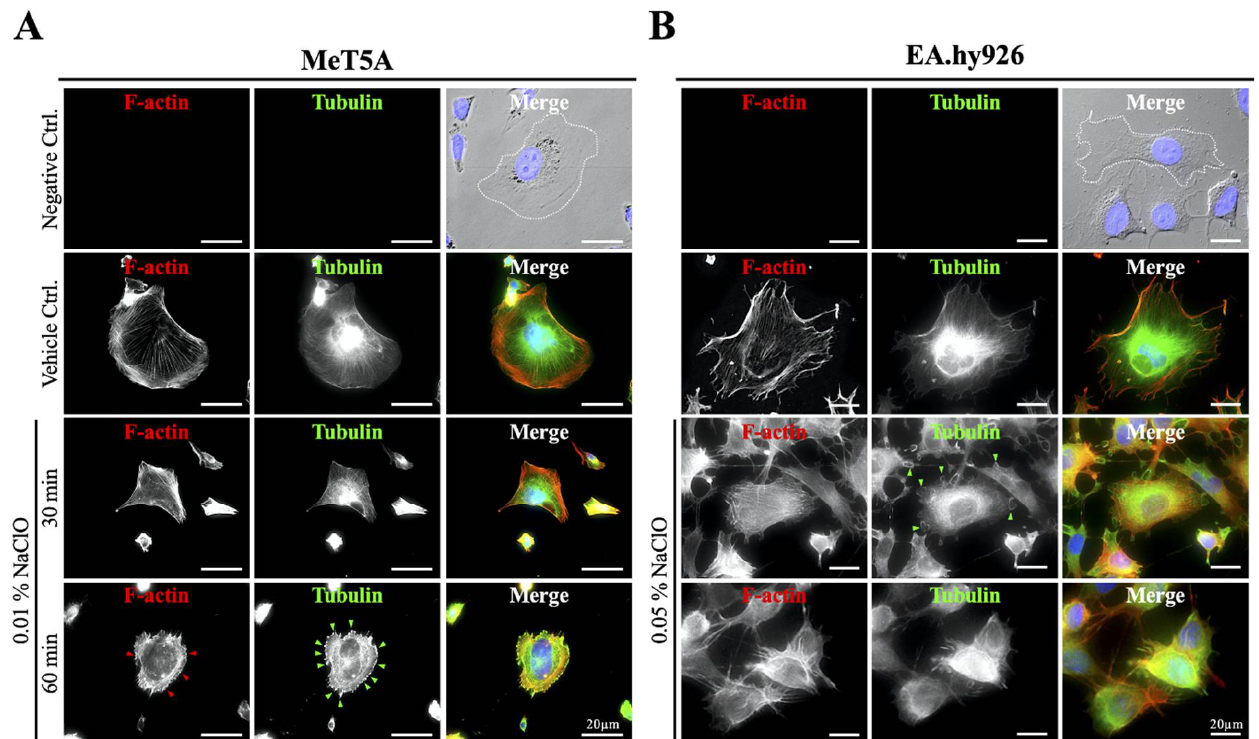
Figure 5. Changes of the cytoskeleton on mesothelial and endothelial cells under NaClO-induced oxidative damages. Double staining of F-actin (labeled in red) and tubulin (labeled in green) was performed on MeT5A and EA.hy926 to observe the changes in cytoskeletal under NaClO stimulation. ( A ) MeT5A showed obvious shrinkage and disorganized patterns of F-actin and tubulin under 0.01%NaClO after 30 and 60 min. Also, punctate accumulation of cytoskeleton (red and green arrowheads) was observed at the edges of the cells. ( B ) Under 0.05% NaClO, EA.hy926 showed a dispersed signal of F-actin and blurred tubulin signal after 30 and 60 min. Besides, ring-shaped membrane ruffling (green arrowheads) was observed after co-incubation of 0.05% NaClO. For each experimental condition, 10 image frames were evaluated, and representative images were presented.